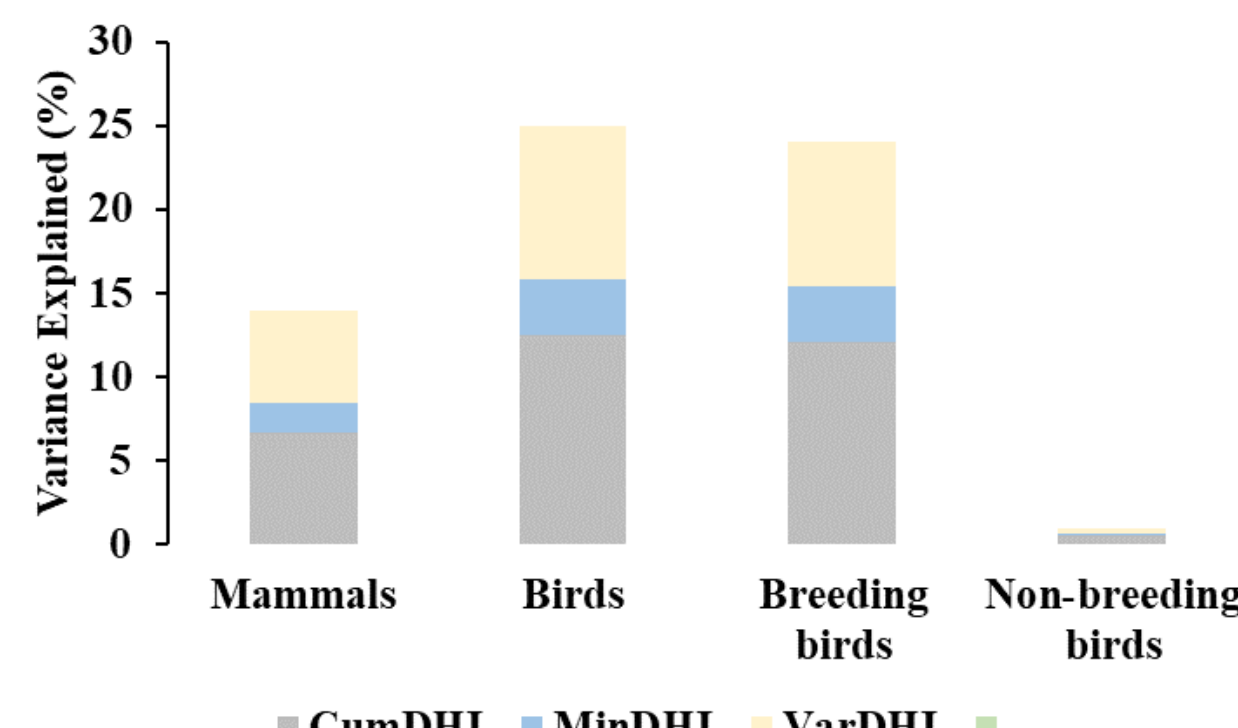
Figure 5. Distribution of species richness of ( a ) mammals, ( b ) birds, ( c ) breeding birds and ( d ) non-breeding birds.